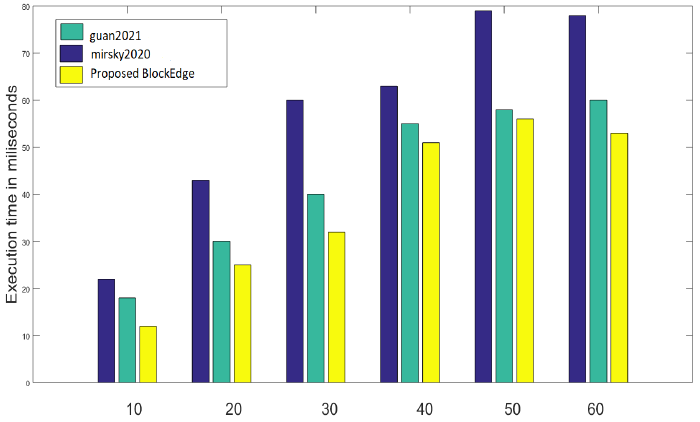
Figure 13. Performance analysis based on processing overhead